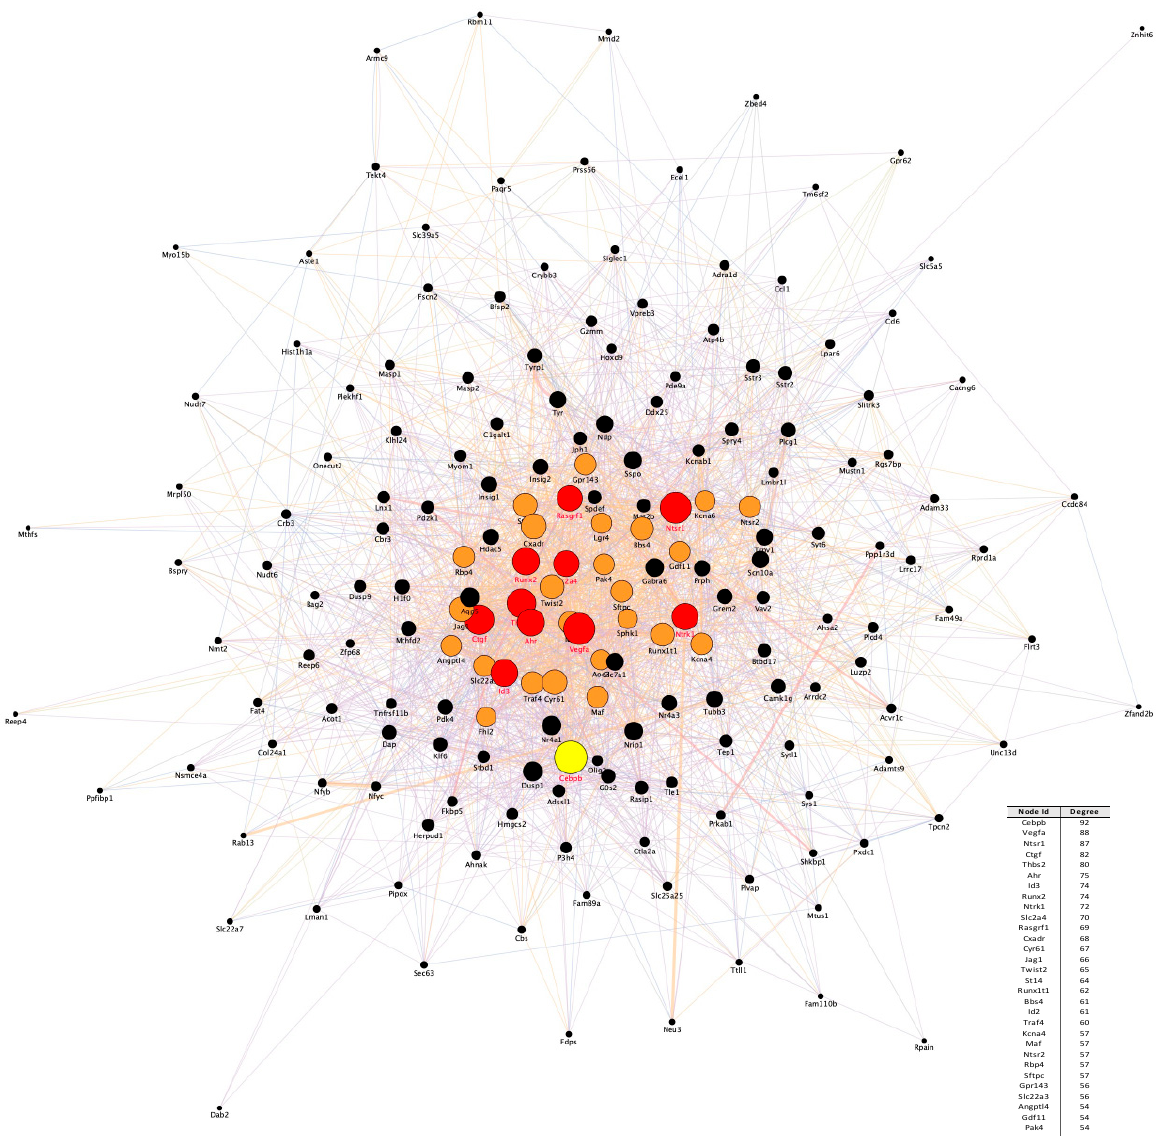
Figure 3. PPI network analysis. The PPI network for the 175 core set genes containing 187 nodes and 2668 interactions was constructed using the STRING website and visualized by Cytoscape (version: 3.8.2,) by mapping the “degree parameter” to node size. As the node size increased, the value of the connectivity degree of node genes increased. Proteins with a degree connectivity of >50 represent the most significant nodes in the PPI network and are colored from orange to red based on their node degree. Cebpb is the most interconnected node (hub) in the network and is colored in yellow. Differently colored “edges” indicate the type of evidence supporting each interaction: dark purple, co-expression; light purple, physical interaction; light blue, co-localization; light green, shared protein domain; orange, predicted; grey,